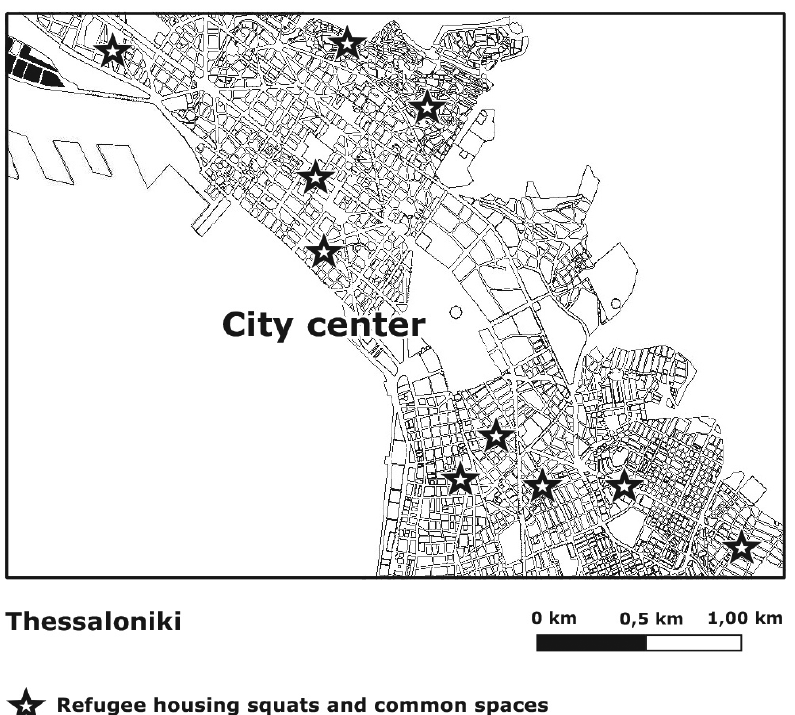
Figure 7. Refugee housing squats and common spaces in Thessaloniki. Source: Authors, map based on the land uses map of Regulatory Urban Plan of Athens and Thessaloniki Metropolitan Areas